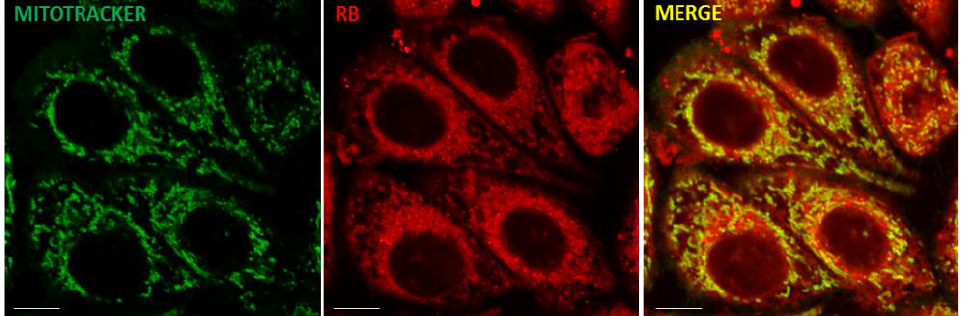
Figure 3. RB and mitochondria localization. T98G cells were incubated for 24 h with RB (25 μM) and analyzed after 24 h p.t. Before confocal microscopy examination, cells were treated with 100 nM MitoTracker Green FM (Invitrogen) for 45 min at 37 °C and then visualized using a Leica TCS SP8 confocal microscope at 63× magnifications (RB exc. = 545 nm; emiss. = 557/700 nm; MitoTracker: exc. = 488 nm; emiss. = 500/540 nm). Scale bars = 5 μm.